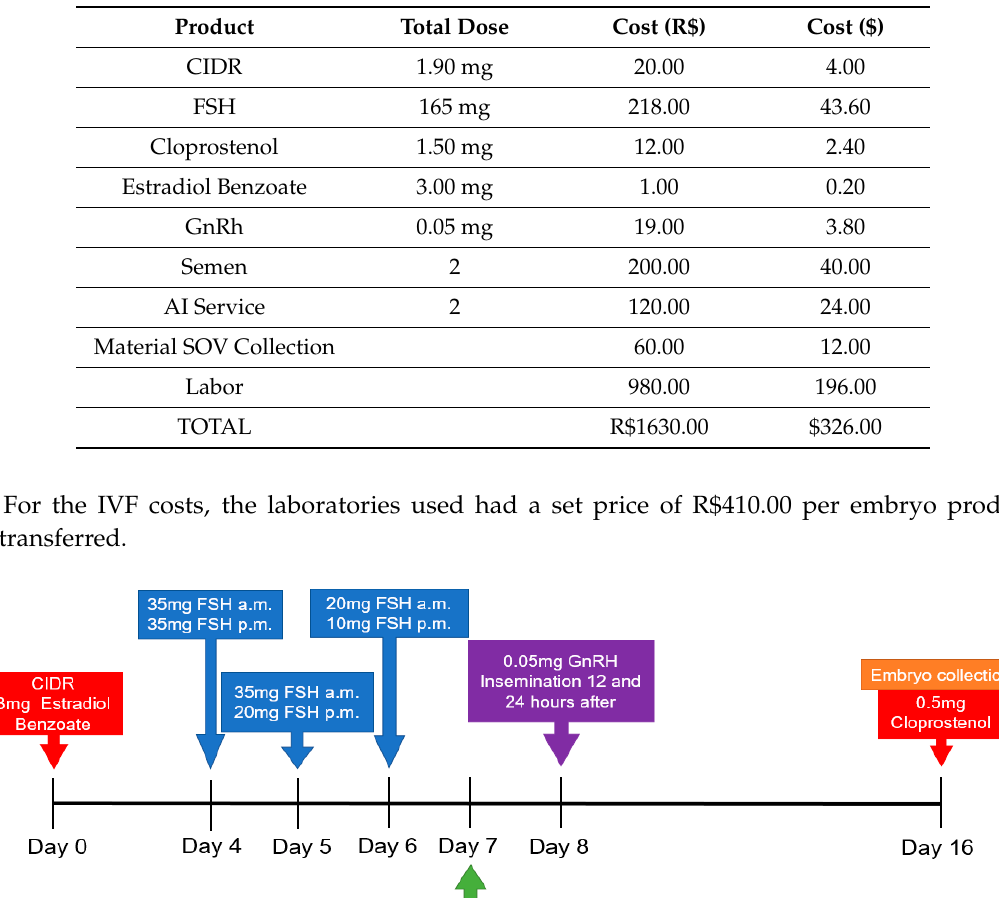
Table 1. Total cost for embryo production and collection using the superovulation protocol (SOV)